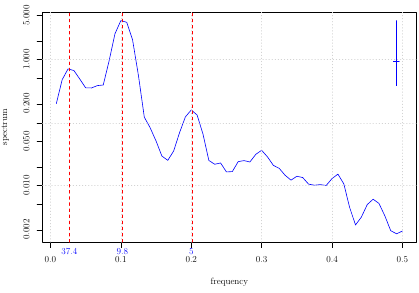
Figure 4 – Spectral density of the Canadian lynx, from 1821 to 1934. There are three main peaks corresponding to a period of 37.4, 9.8 and 5 respectively. The highest one is related to the under- lying population dynamic that presents an asymmetric cycle where the increasing phase and the decreasing take about 6 and 3 years, respectively.